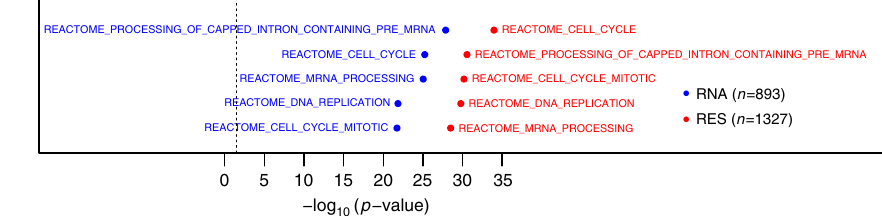
Fig. 4 Correlation between transcriptomic data and orthogonal molecular features. a , b Enrichment of Myc transcriptional target genes from gene sets “ SCHUHMACHER_MYC_TARGETS_UP ” and “ KEGG_RIBOSOME ” in the top 100 Myc RPPA correlated genes based on RNA ( p value of 5.1e − 4) ( a ) or RES ( p value of 1.2e − 12) ( b ). Spearman correlation coef fi cient at false discovery rate of 0.05 based on the Benjamini & Hochberg method was marked by an orange dashed line. c Enrichment of “ KEGG_OXIDATIVE_PHOSPHORYLTION ” gene set in genes signi fi cantly (adjusted p < 0.05) correlated with multiple TCA cycle metabolite levels by RNA or RES. d Number of genes found to associate with drug sensitivity based on signi fi cant (adjusted p < 0.001) negative Pearson correlation between their expression levels and the high-concentration effect level (Amax) of the drugs tested. e Top 5 gene sets highly enriched in paclitaxel sensitivity correlated genes by RNA or RES. These include cell cycle and DNA replication gene sets, consistent with the role of paclitaxel in targeting mitosis. a – c Based on NCI60 cell line data, d , e are based on CCLE cell line